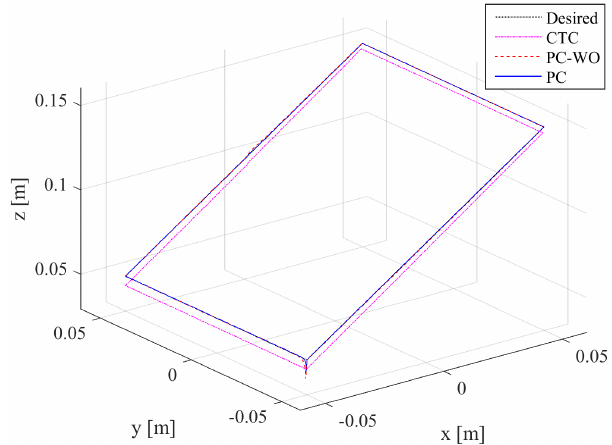
Figure 6. Block diagram representation of the proposed robust task-space control